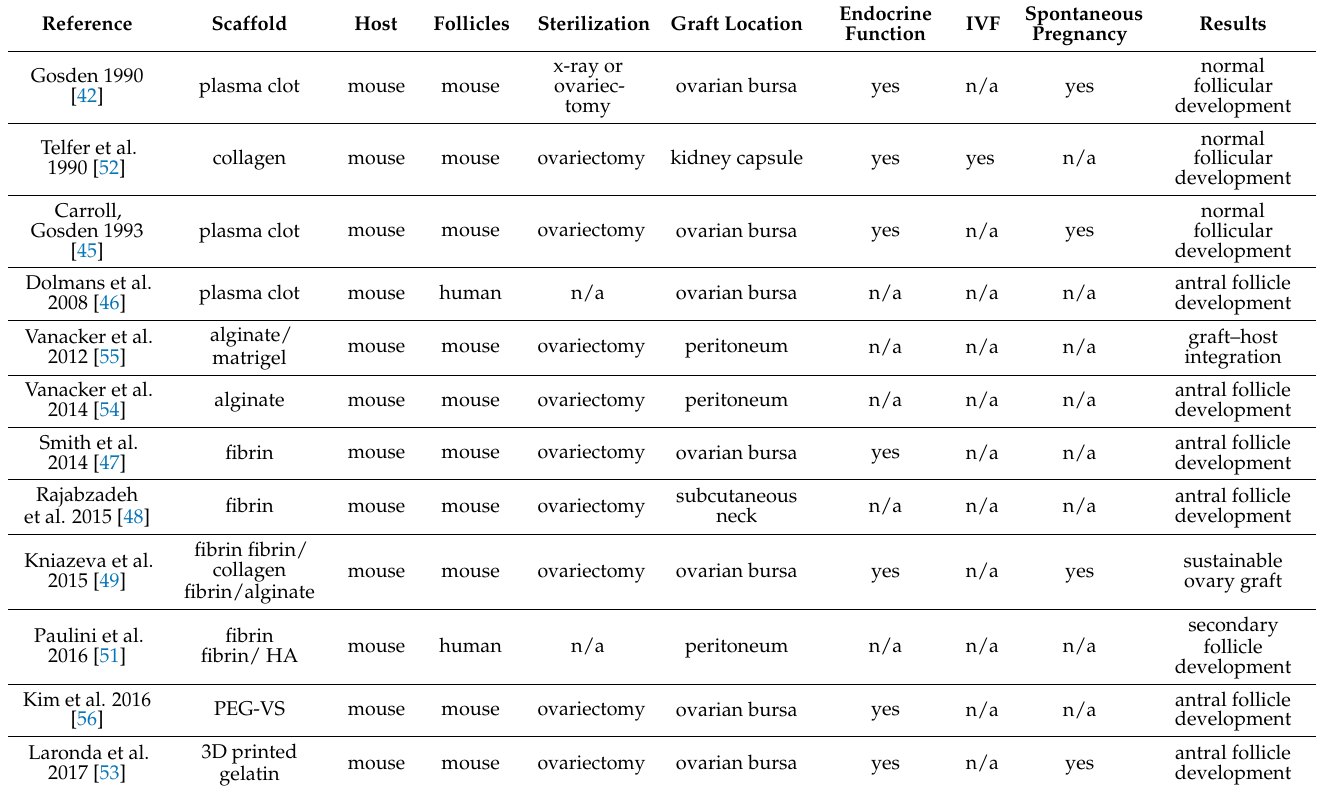
Table 1. Tissue engineering ovary models in